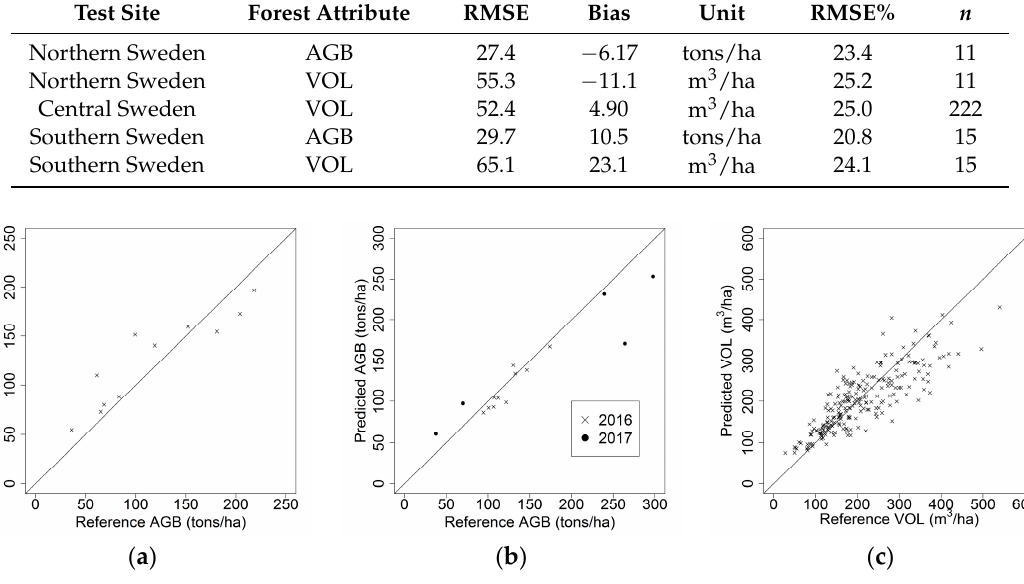
Table 3. Evaluation statistics. Prediction accuracy (RMSE) and bias. n denotes the number of stands.